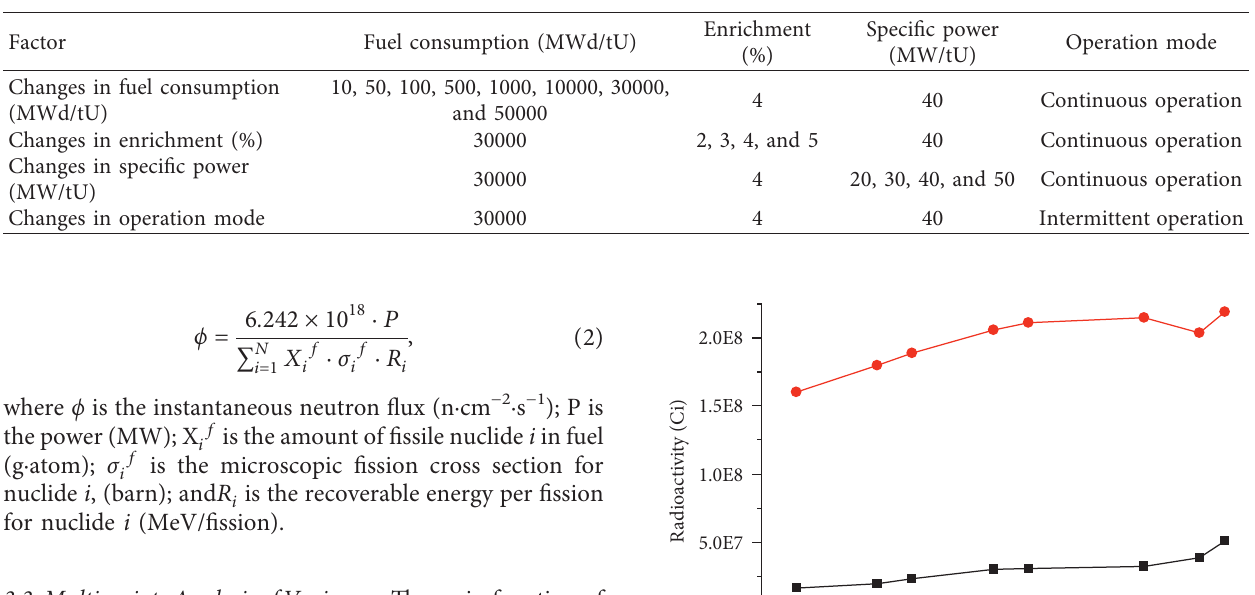
Table 2: Values of each factor.